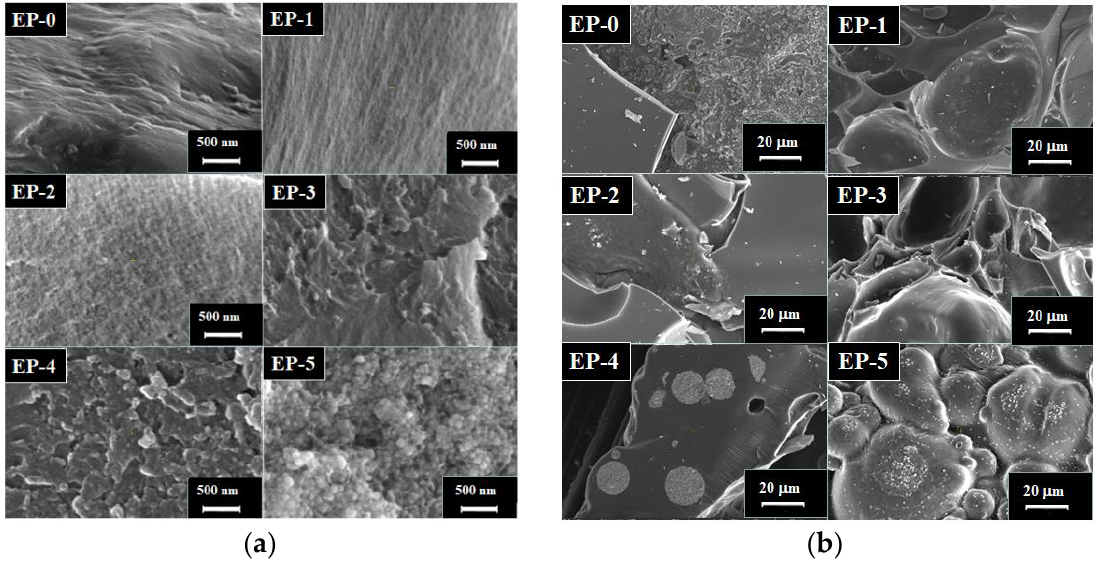
Figure 4. ( a ) SEM micrographs of as synthesized epoxy thermoset surfaces; ( b ) SEM micrographs of epoxy thermosets heated up to 700 °C, with the heating rate of 10 °C/min, under nitrogen atmosphere. The EDX mapping of EP-3 (Figure S7) revealed the distribution of phosphorus and Cu atoms, suggesting a uniform distribution of the segments coming from BPH and a homogenous distribution and a good compatibility of hyperbranched phthalocyanine polymer HPc with epoxy matrix. The EDX mapping of EP-4 (Figure 5a) shows the uniform distribution of phosphorus and Cu atoms. The distribution of Ba and Ti atoms in the epoxy matrix, however, suggested that some agglomeration of BaTiO 3 nanoparticles appeared. In the EDX diagram of EP-4 (Figure 6), the peak at 4.5 KeV revealed the existence of barium and titanium atoms. The presence of sulfur, phosphorus, and copper atoms can be also observed in the EDX